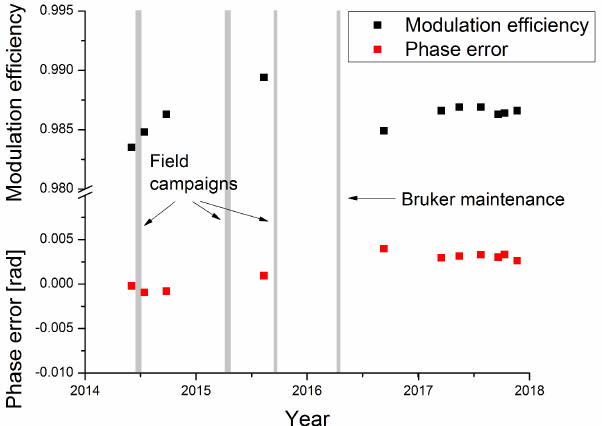
Figure 1. ILS time series of the reference EM27/SUN. Results for modulation efficiency and phase error were obtained with LINE- FIT 14.5. The mean value of the modulation efficiency is 0.9862 with a standard deviation of 0.0015. For the phase error an aver- age value of 0 . 0019 ± 0 . 0018 is observed. As can be seen from the closely spaced measurements in 2017, there is no seasonality in the ILS values. Grey areas denote periods of transportation of the in- strument.